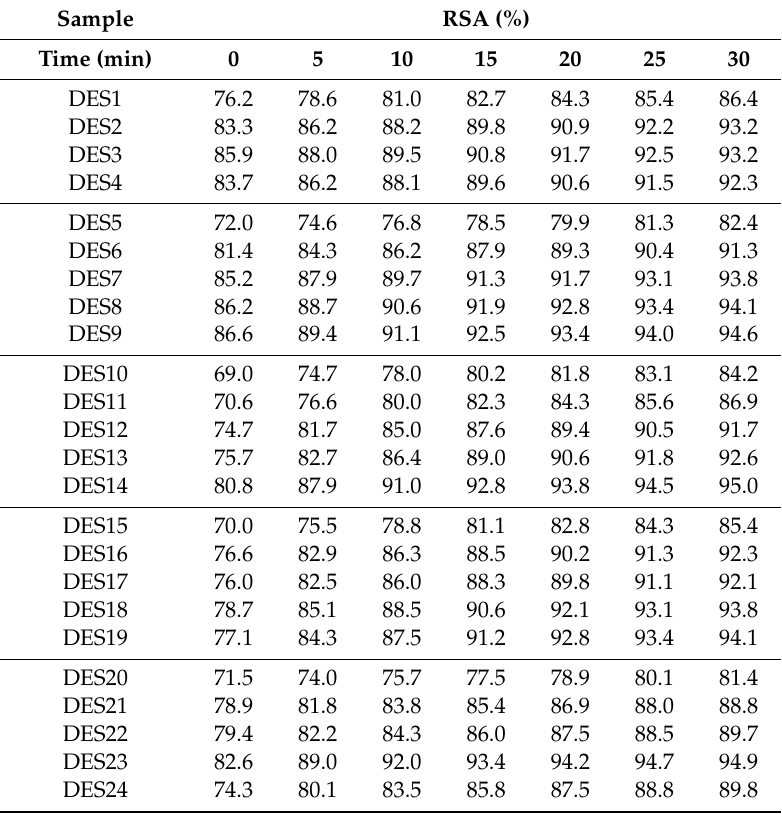
Table 6. 2,2-diphenyl-1-picrylhydrazyl radical ( • DPPH) assay of antioxidant activity (RSA) for di ff erent